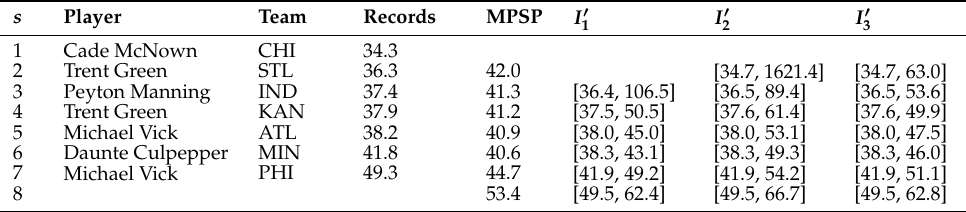
Table 6. World records (2000–2019), maximum product of spacings predictor and (approximate) 90% prediction intervals I (cid:48) , I (cid:48) and I (cid:48) for the next record based on the previous records for the fantasy 2 3 1 points of